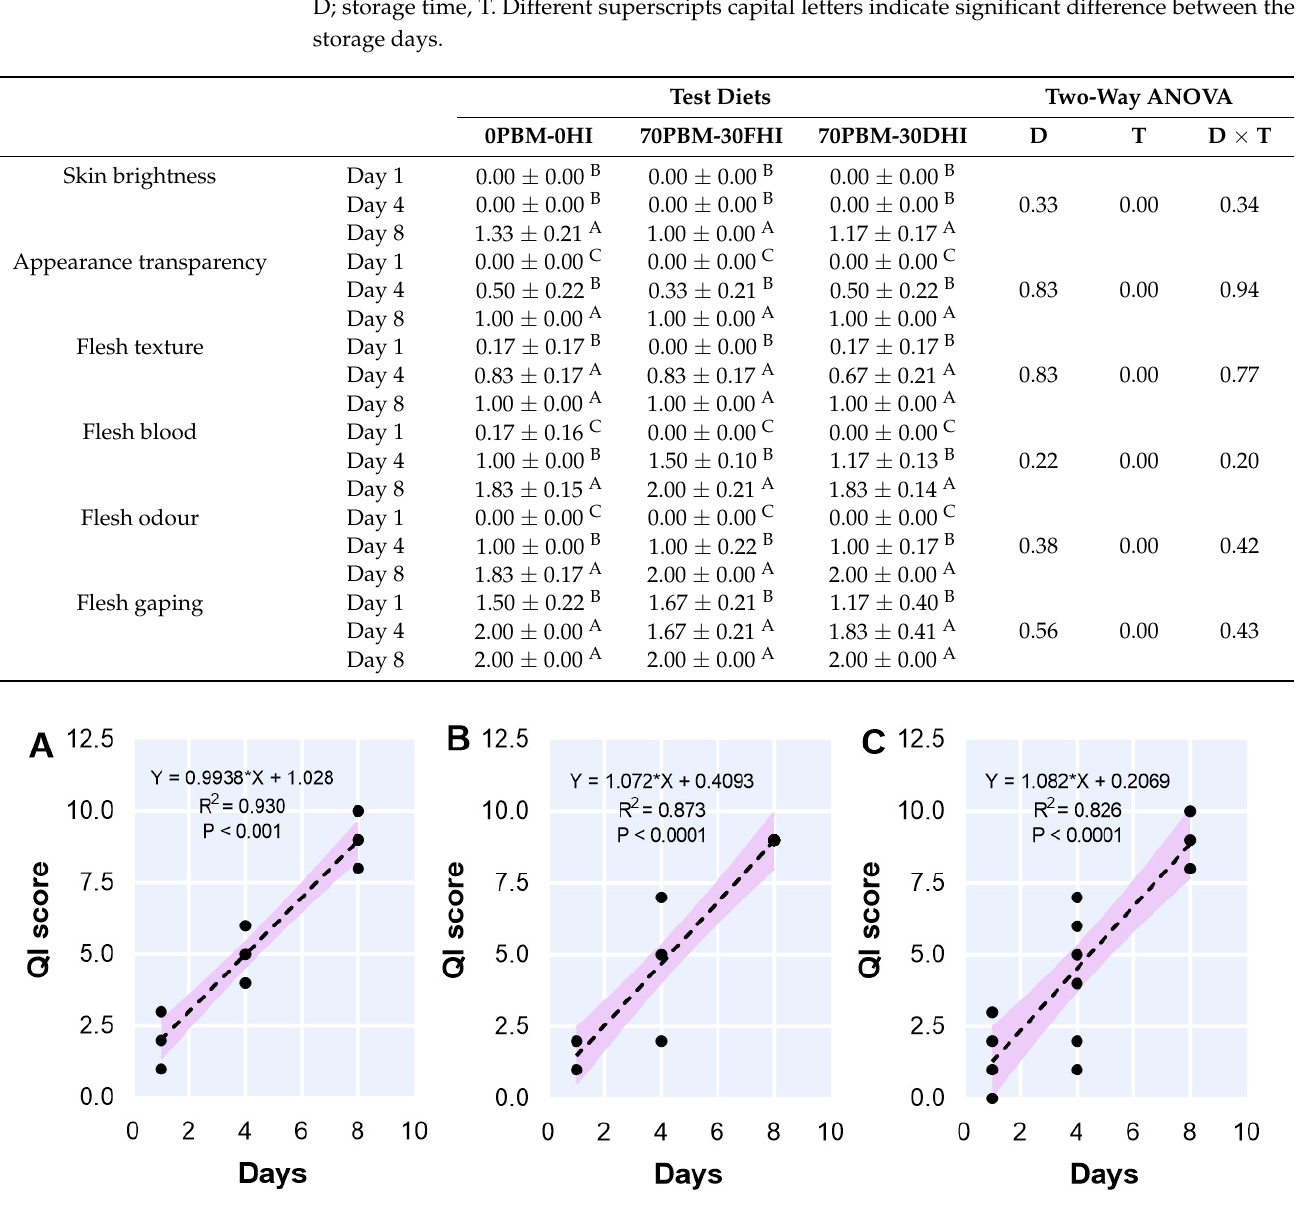
Figure 5. Correlations between the quality index (QI) values and storage times for the test diets, including 0PBM-0HI ( A ), 70PBM-30FHI ( B ), and 70PBM-30DHI ( C ).